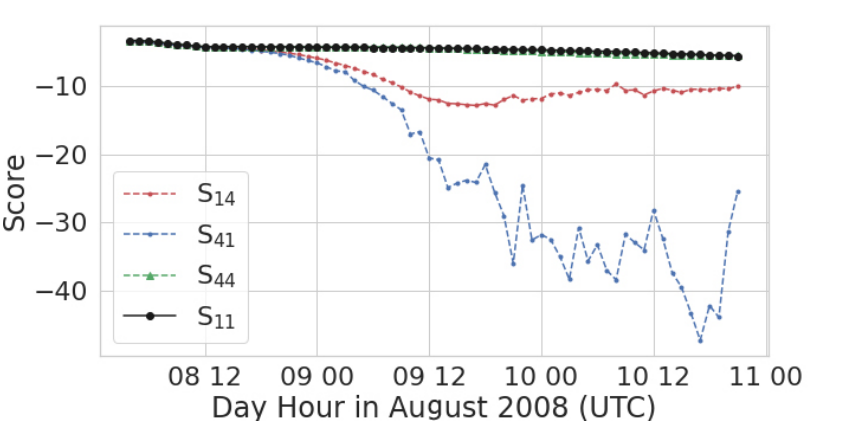
Figure 7. The score, S ij , as a function of time. The score is described in the